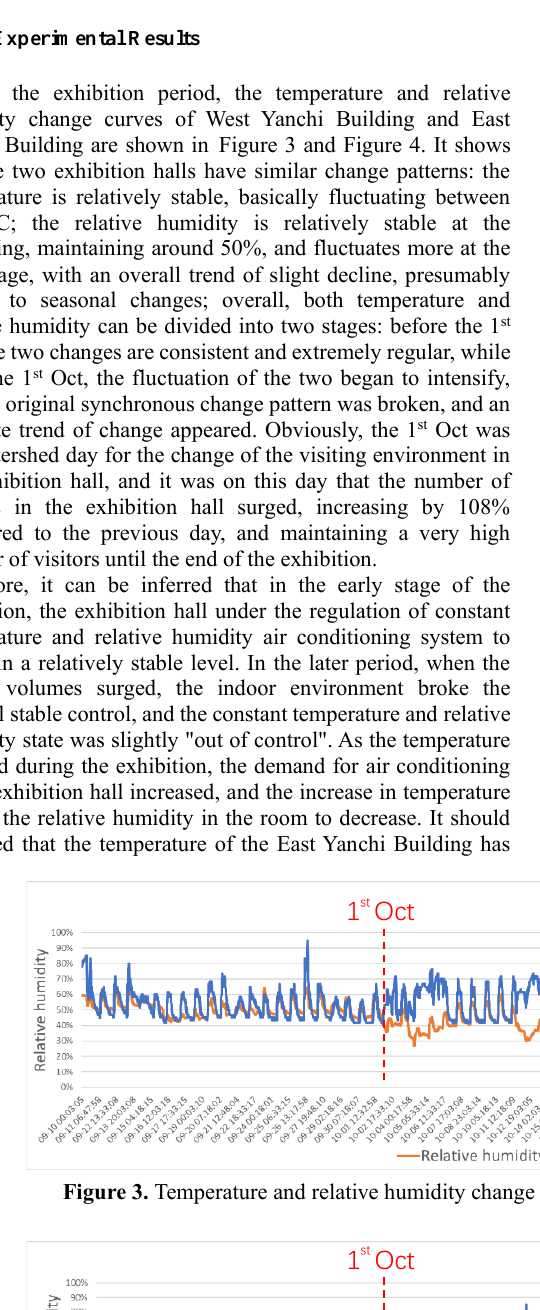
Figure 3. Temperature and relative humidity change curve of West Yanchi Building during the exhibition 1 st